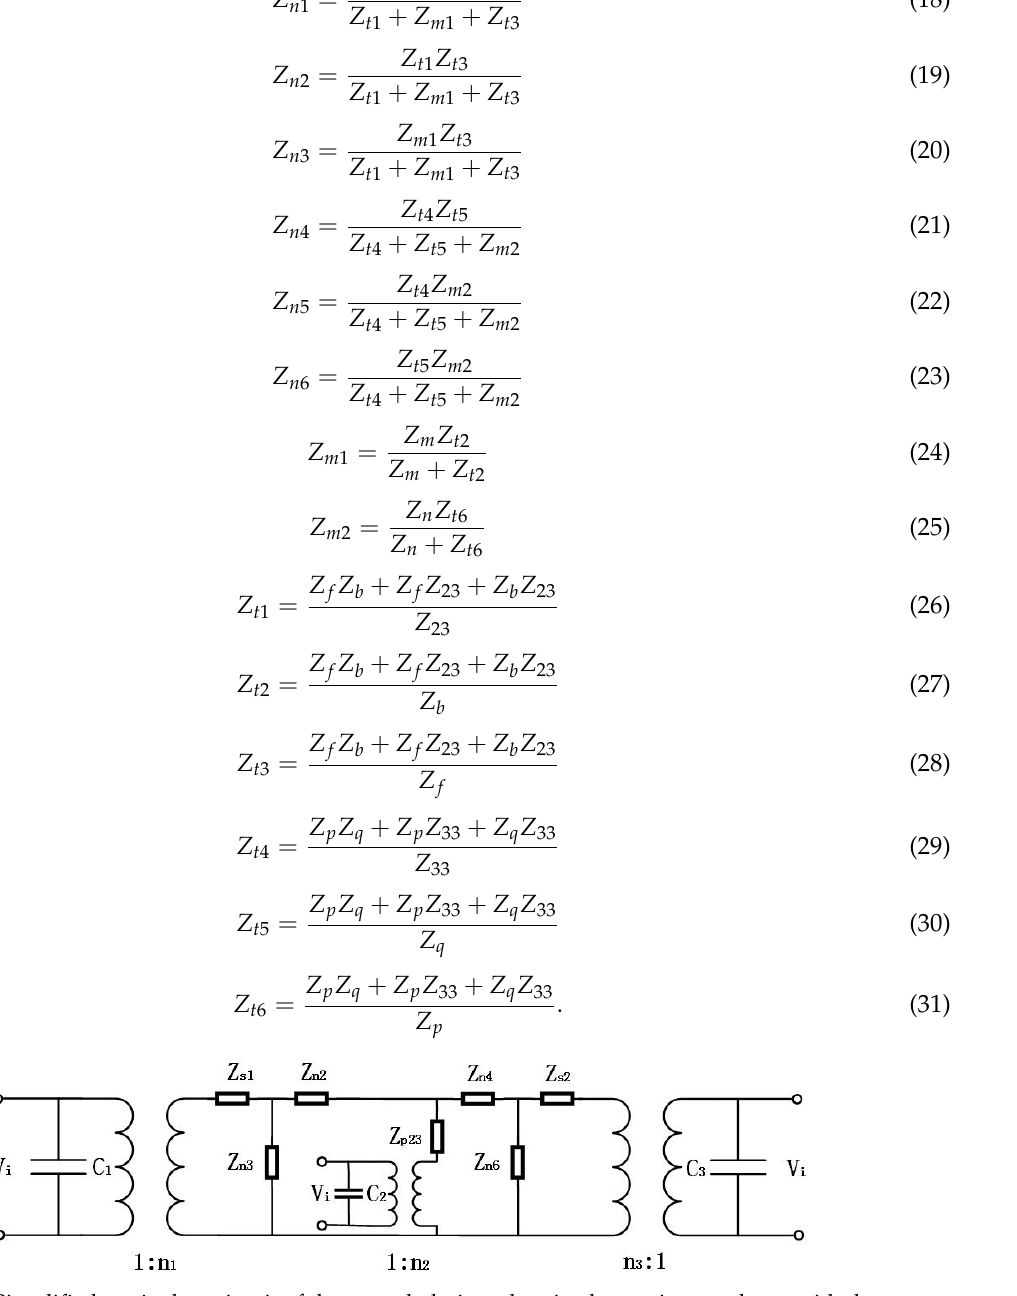
Figure 5. Simplified equivalent circuit of the cascaded piezoelectric ultrasonic transducer with three sets of piezoelectric ceramic stacks.